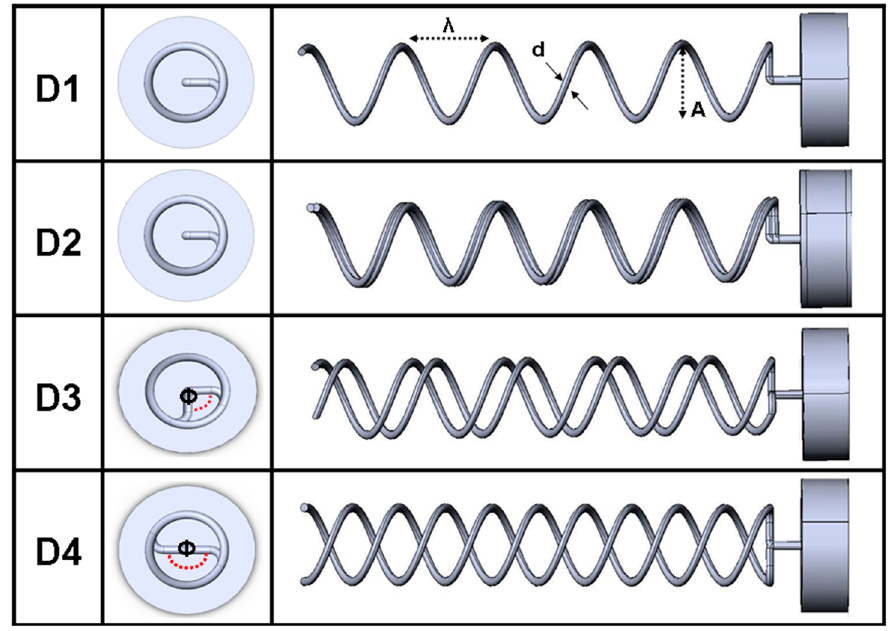
Figure 2. All flagellar configurations tested in the present study. D1: Baseline single-flagellum model. D2: Overlapping bundle state of two nearby flagella. D3: Two flagella with 90-degree relative phase shift. D4: Two flagella with 180-degree relative phase shift. λ =10 mm, A = 3.175 mm.